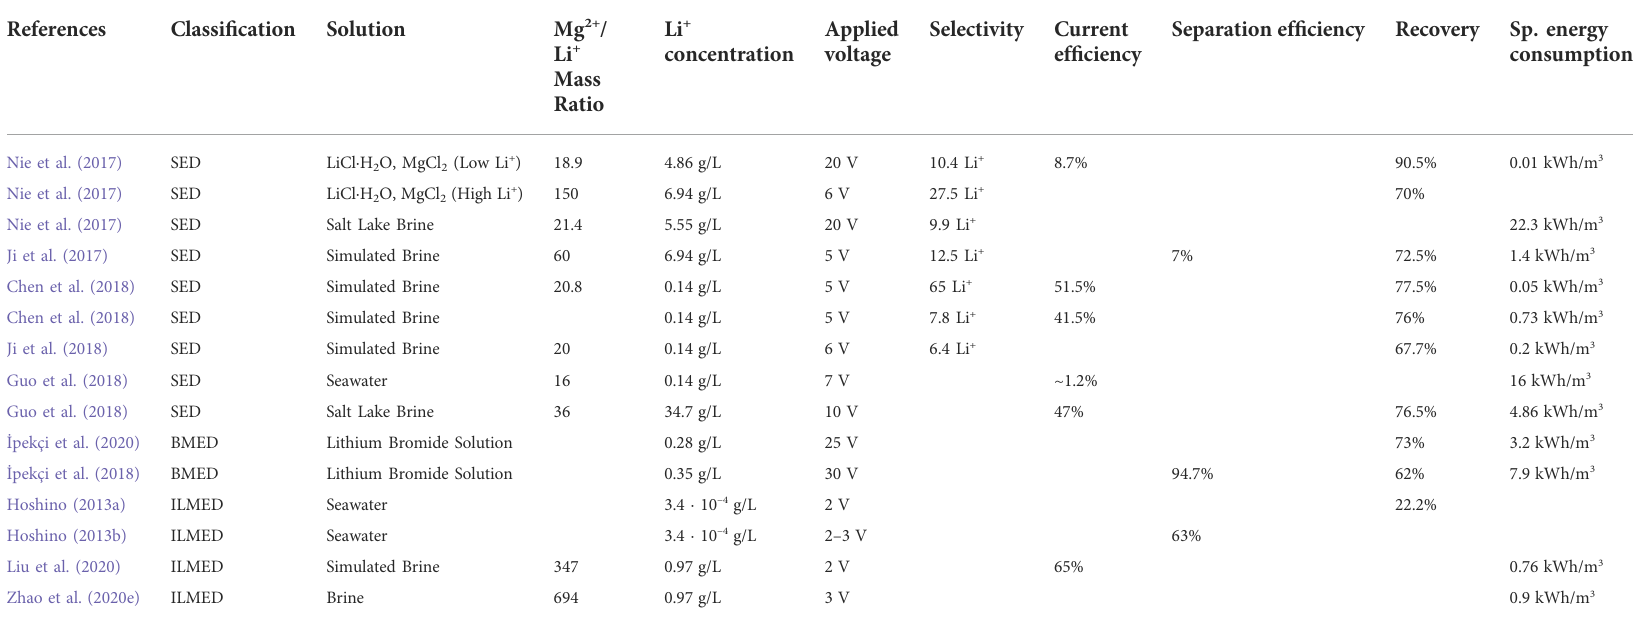
TABLE 10 Li + ED extraction from salt lake brines, simulated brines, and